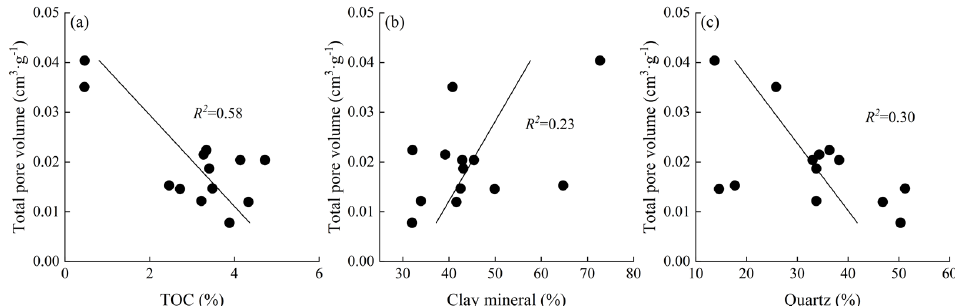
Figure 10. ( a ) Relationship between total pore volume and TOC; ( b ) Relationship between total pore volume and clay mineral; ( c ) Relationship between total pore volume and quartz.